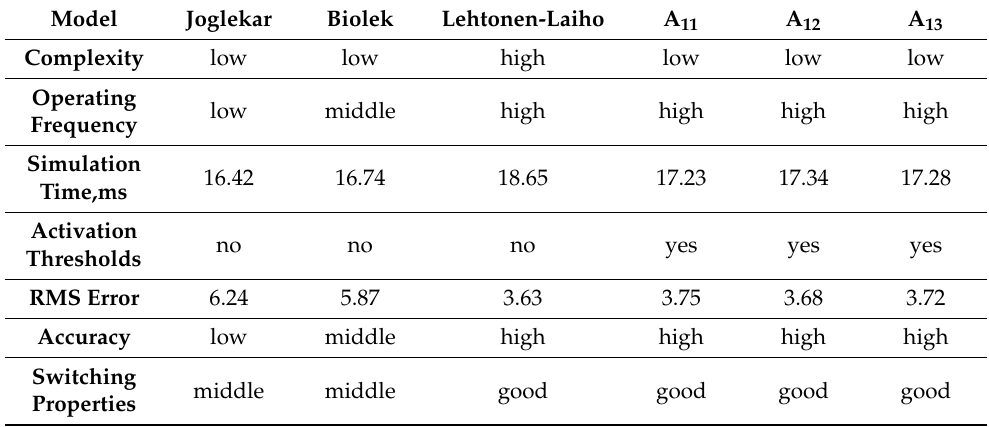
Table 1. A comparison of the applied standard and modified memristor models according to several important criteria.